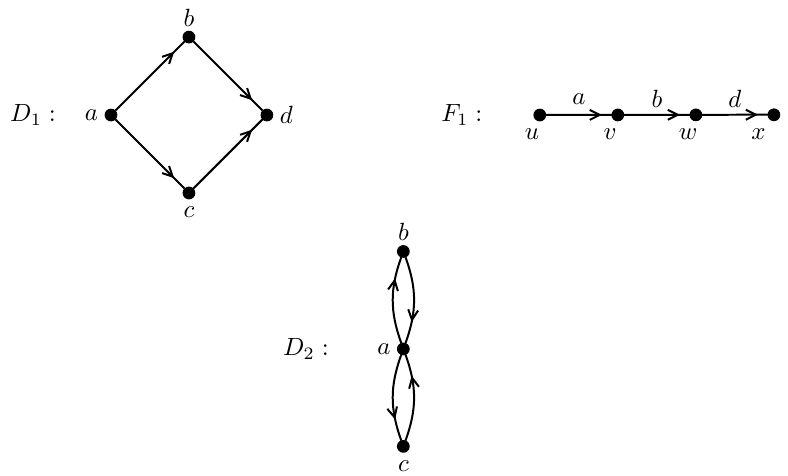
Figure 9: A forbidden digraph in a line digraph.